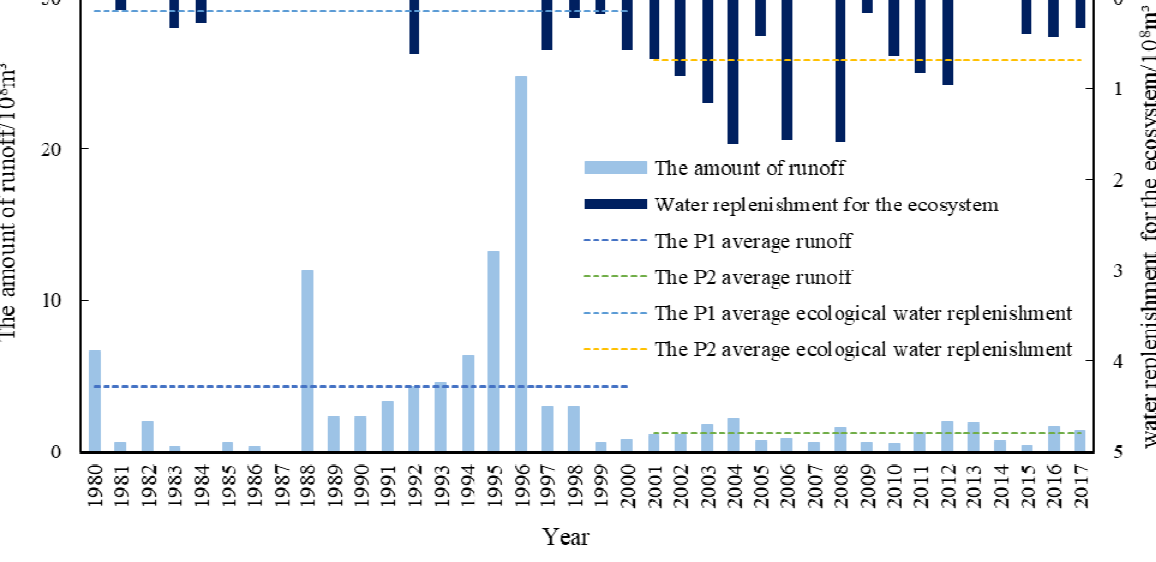
Figure 10. Changes in the water inflow into Baiyang Lake and the water replenishment for the ecosystem from 1980 to 2017 [35–39].